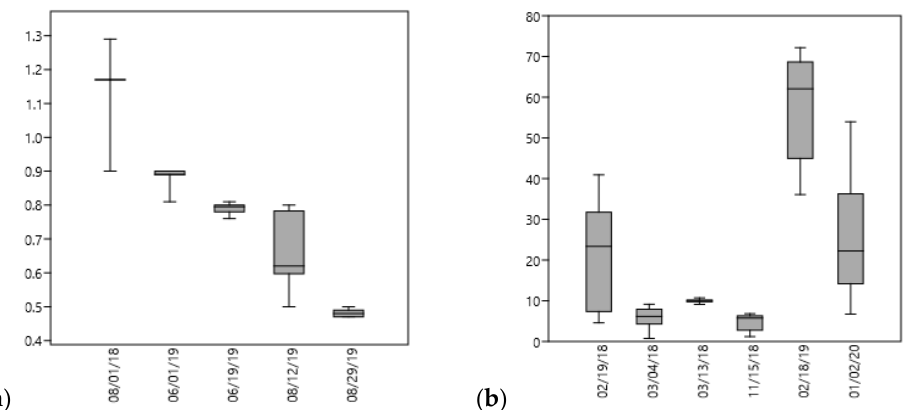
Figure 2. Flow distribution (m 3 /s) in each monitoring event, separated into dry ( a ) and flood ( b ) events.